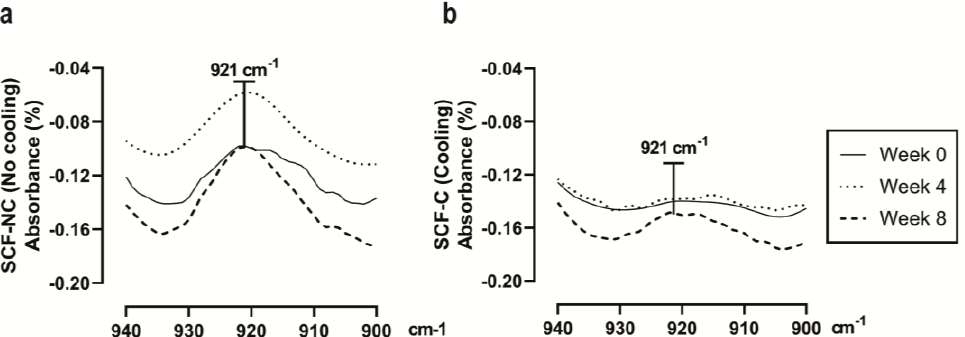
Figure 6. FTIR spectra. ( a ) the SCF-NC group from 930 to 910 cm − 1 . At the end of the immersion test, an increment of 76% in the peak area and height at 921 cm − 1 was observed; ( b ) the SCF-C group from 930 to 910 cm − 1 . An increment of 139% was reached for week 8 at 921 cm − 1 . In both cases, the peaks increased with the immersion period .